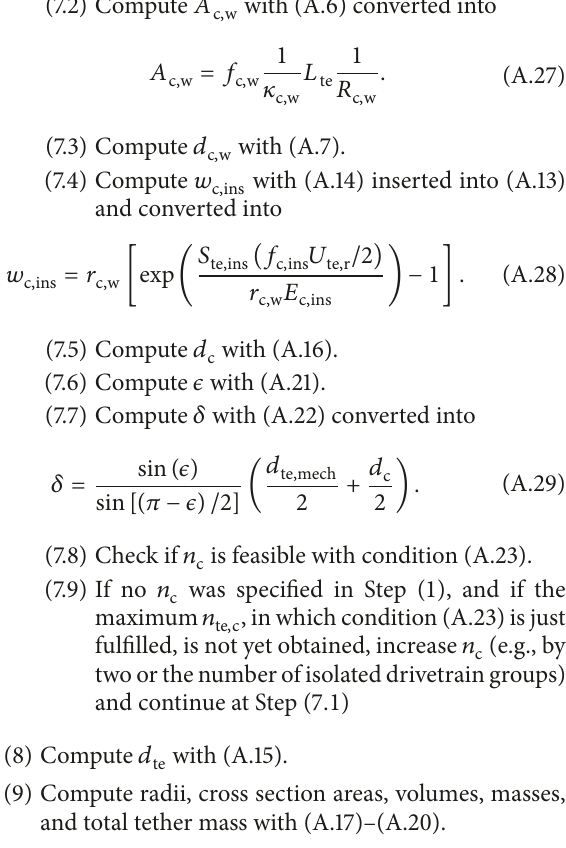
Table 7: Considered ratings and material